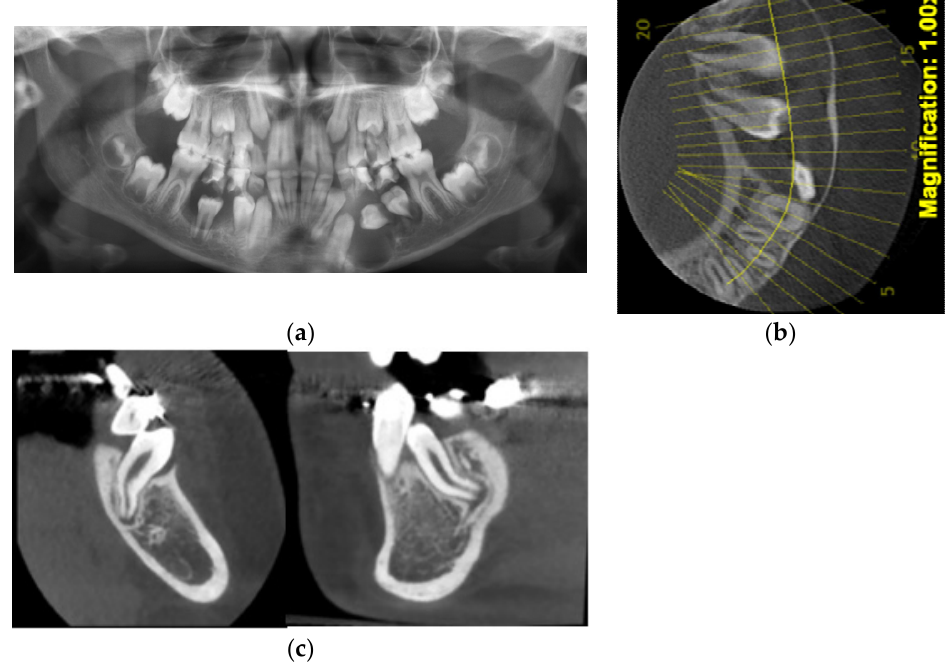
Figure 4. ( a ) Initial panoramic X-ray revealed large DCs on both sides of the mandible. ( b ) CBCT image showing the labiolingual orientation of the lower left first and second premolars. ( c ) CBCT showing root DL of the left first premolar.